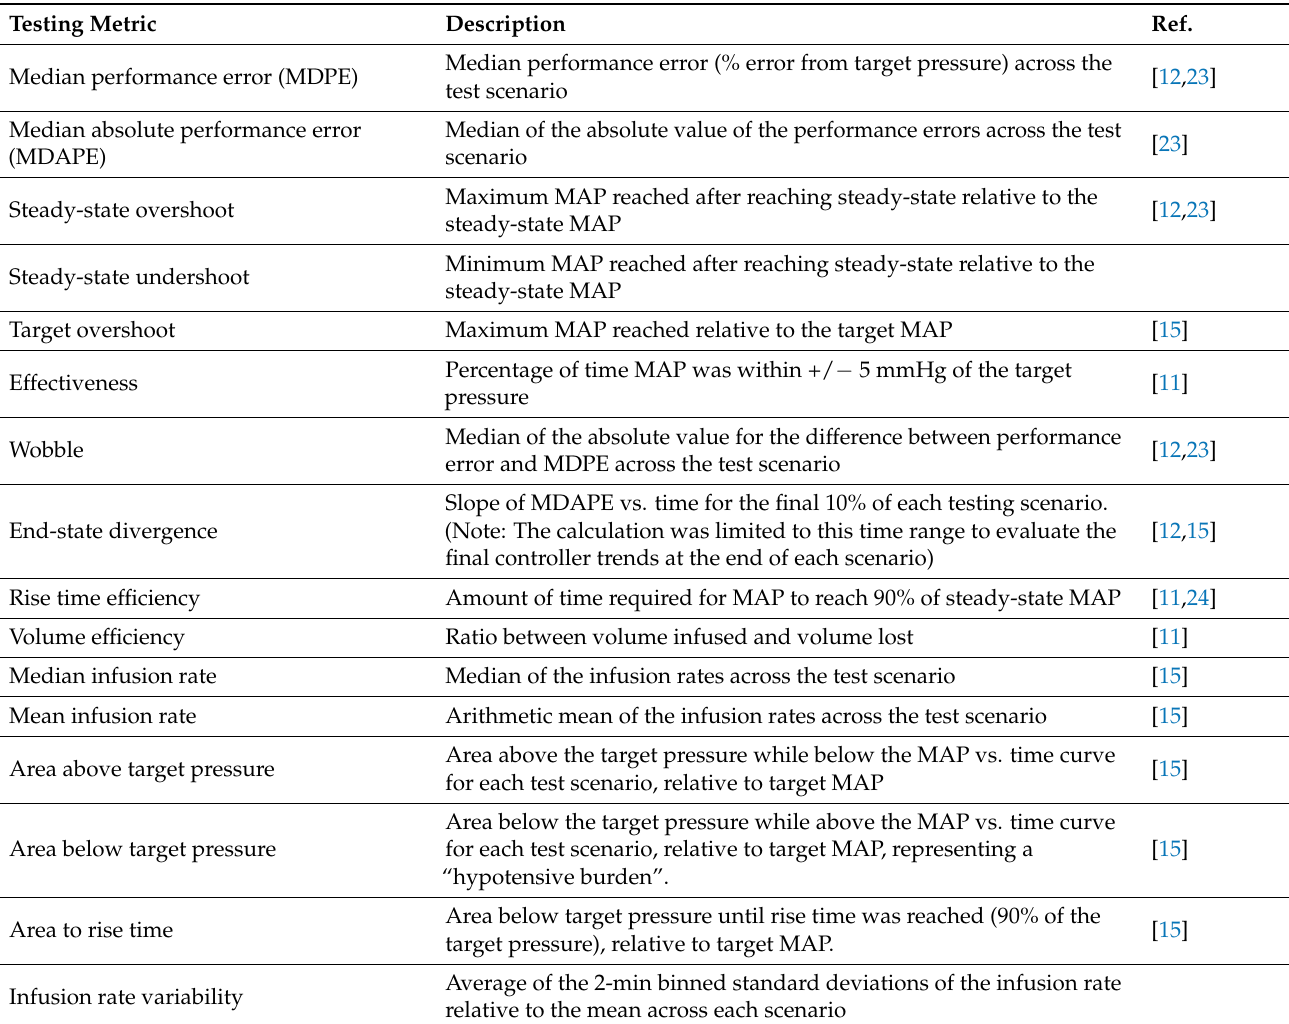
Table 2. Summary of controller performance metrics evaluated in each testing